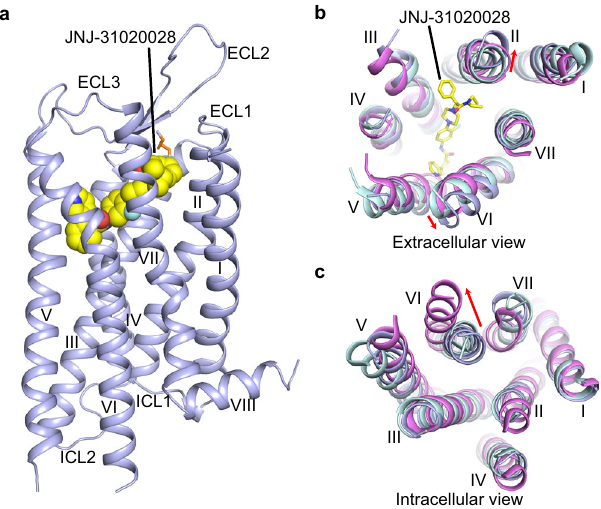
Fig. 1 Overall structure of Y 2 R – JNJ-31020028 complex. a Side view of the Y 2 R – JNJ-31020028 structure. Y 2 R is shown in light blue cartoon representation. JNJ-31020028 (carbon in yellow, nitrogen in blue, oxygen in red, fl uorine in cyan) is shown in sphere representation. The disul fi de bond is shown as orange sticks. b , c Structural comparison of Y 2 R with inactive Y 1 R (PDB code: 5ZBQ) and active NTSR1 (PDB code: 6OS9). The helical bundles of Y 2 R, Y 1 R, and NTSR1 are colored light blue, light cyan, and pink, respectively. JNJ-31020028 is shown as sticks . b Extracellular view. Red arrows indicate the movements of helices II and VI in the Y 2 R structure compared to the structures of Y 1 R and NTSR1. c Intracellular view. Red arrow indicates the conformational change of helix VI in the active NTSR1 structure relative to the structures of Y 1 R and Y 2